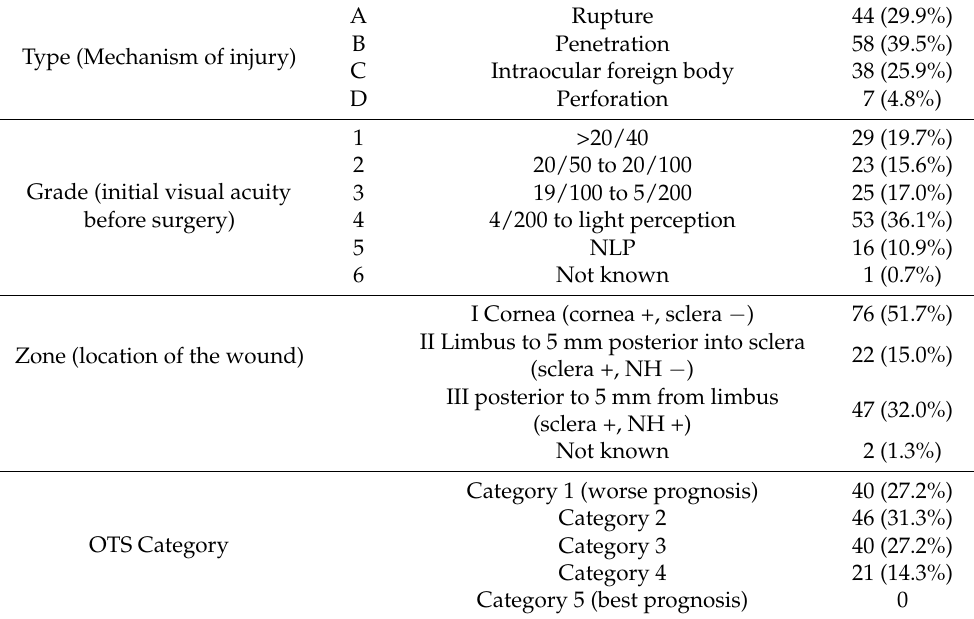
Table 3. Classification of the open globe injury.